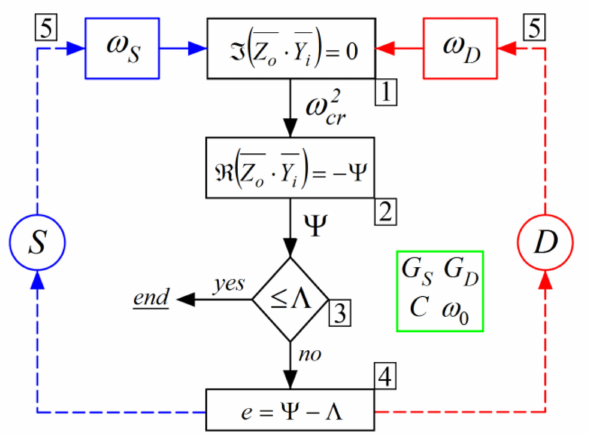
Figure 4. Stability assessment iterative process implementing the